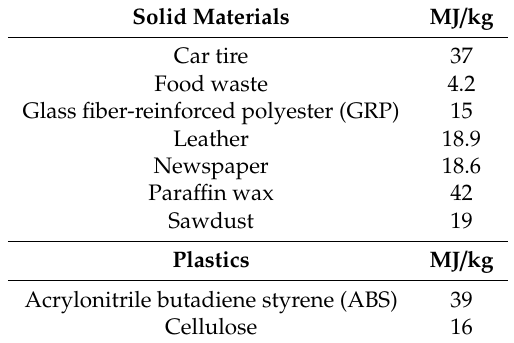
Table 1. Normalized Iranian waste properties. All numbers are reported as their lower heating values (LHV).